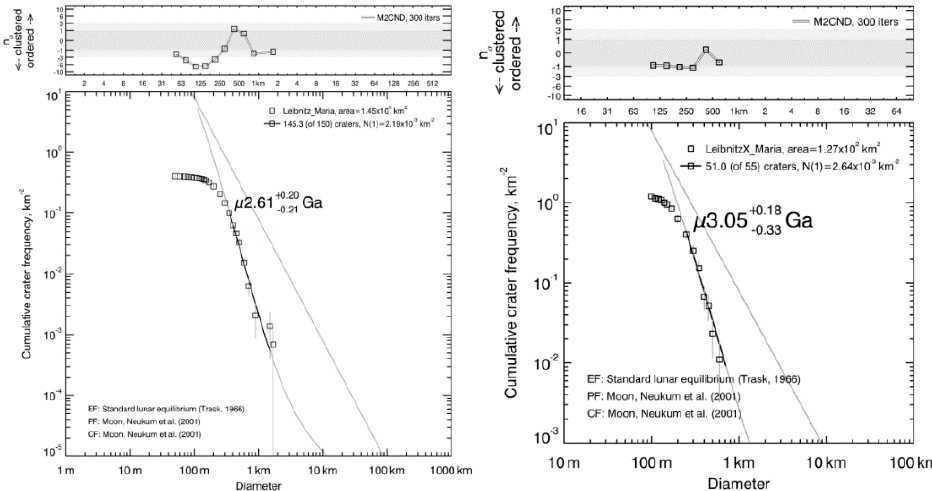
Figure 10. Dating results for the basalt units mapped in Figure 9. Leibnitz_Maria and LeibnitzX_Maria correspond to the basalt units ‘ h ’ and ‘ i ’ in Figure 9. The equilibrium function is the standard lunar equilibrium of [35], while both the production and chronology functions are from [36].